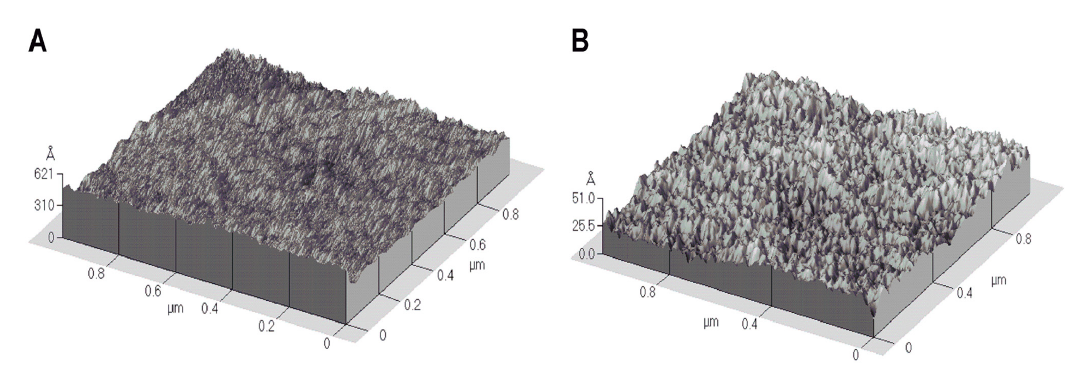
Fig 8. AFM topographic images for A. S1-(PDMS)